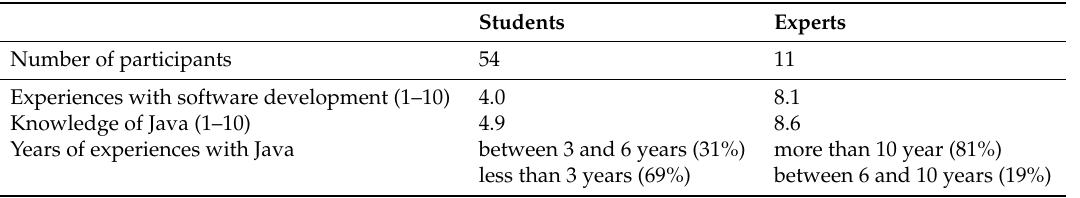
Table 4. Profile of participating students and